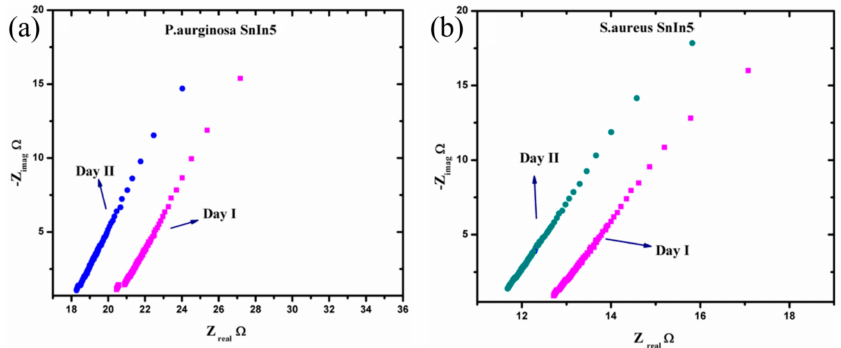
Figure 9. Nyquist plot response from ( a ) P. aeruginosa and ( b ) S. aureus in two consecutive analysis.